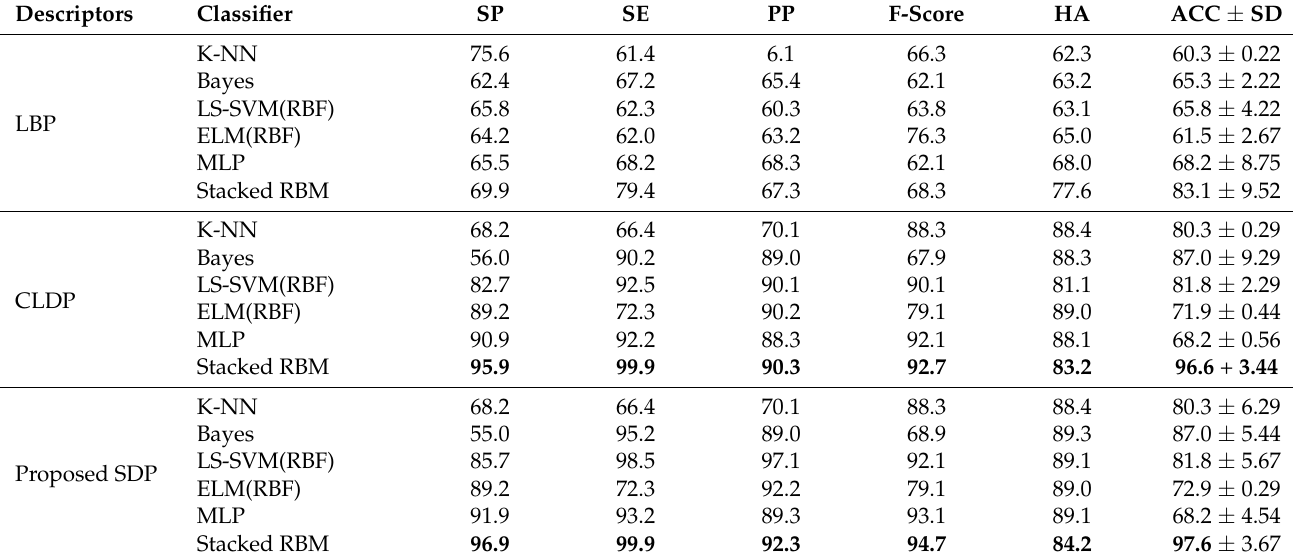
Table 9. Classification outcomes of pictures from DermIS.